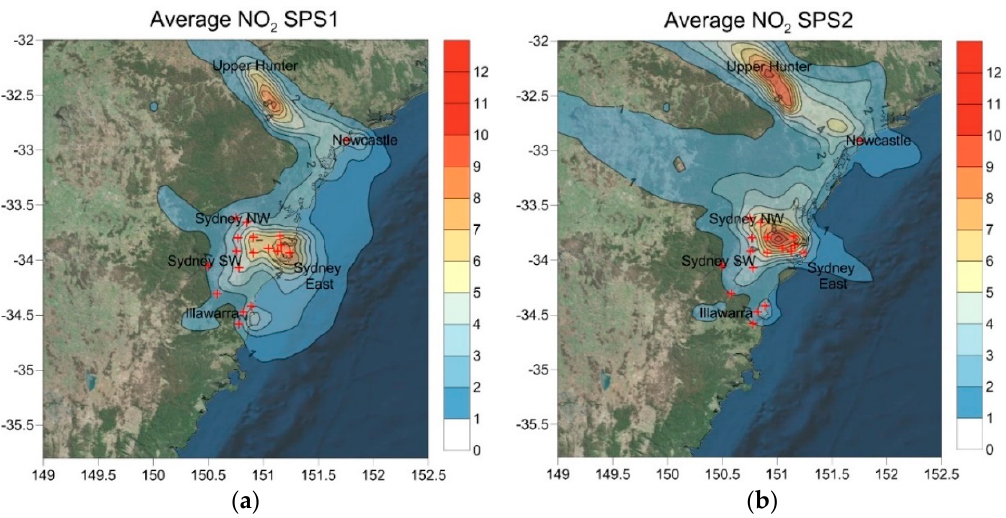
Figure 14. Spatial distribution of NO 2 concentrations (ppb) predicted by CCAM ‐ CTM with GMR 9 ‐ km horizontal resolution domain. The hourly average NO 2 concentrations for the period of: ( a ) SPS1; and ( b ) SPS2. Red cross signs indicate locations of OEH stations.